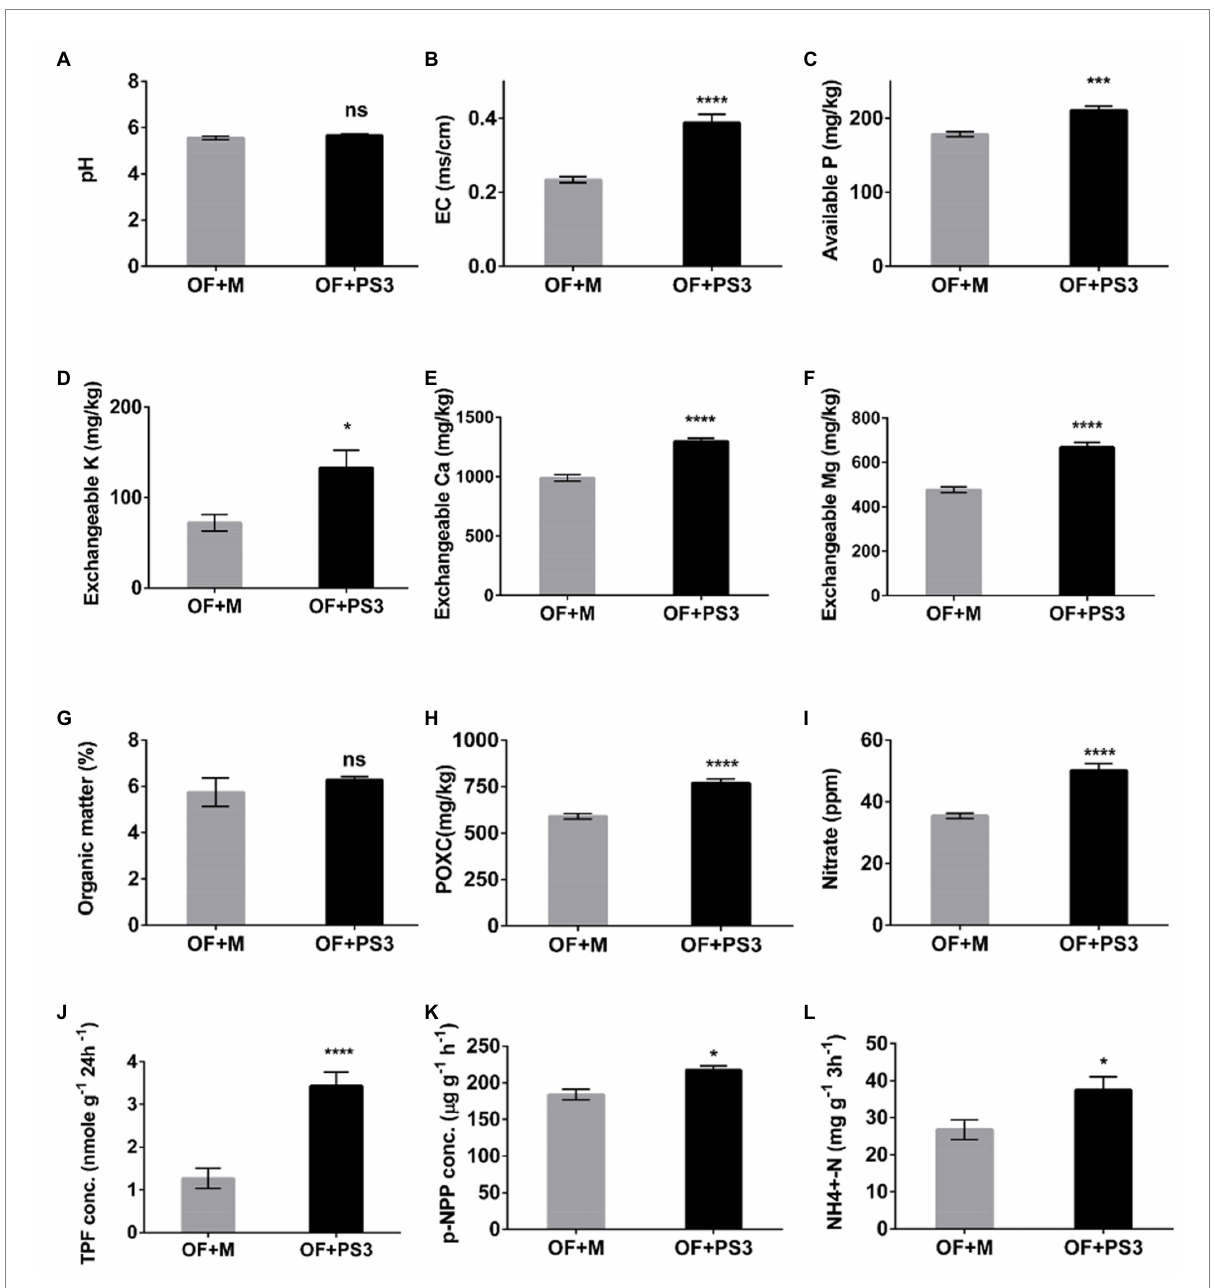
FIGURE 4 Physicochemical properties and enzyme activities of soil samples under different treatments. (A) pH. (B) Electroconductivity (EC). (C) Available phosphorus (P). (D) Exchangeable potassium (Ex.K). (E) Exchangeable calcium (Ex.Ca). (F) Exchangeable magnesium (Ex.Mg). (G) Organic matter (%). (H) Available carbon (POXC). (I) Nitrate. (J) TPF concentration (represented as soil dehydrogenase activity). (K) p -NPP concentration (represented as phosphatase activity). (L) NH4 + -N (represented as urease activity). TPF, triphenylformazan; p -NPP, para-nitrophenylphosphate. The statistical test was based on Welch’s t-test (ns, p ≥ 0.05; * p < 0.05, *** p < 0.005, and **** p < 0.001). Data are five biological replicates and expressed as the mean ±